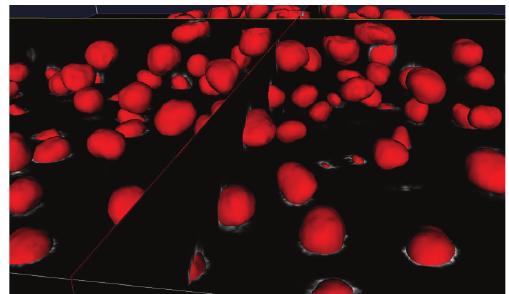
Figure 7: Isosurface of nuclei segmentation superimposed to three orthoslices of raw data.